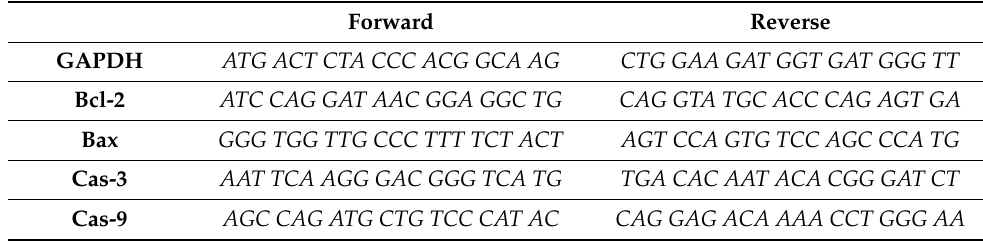
Table 1. Primer sequences were used in RT-PCR.